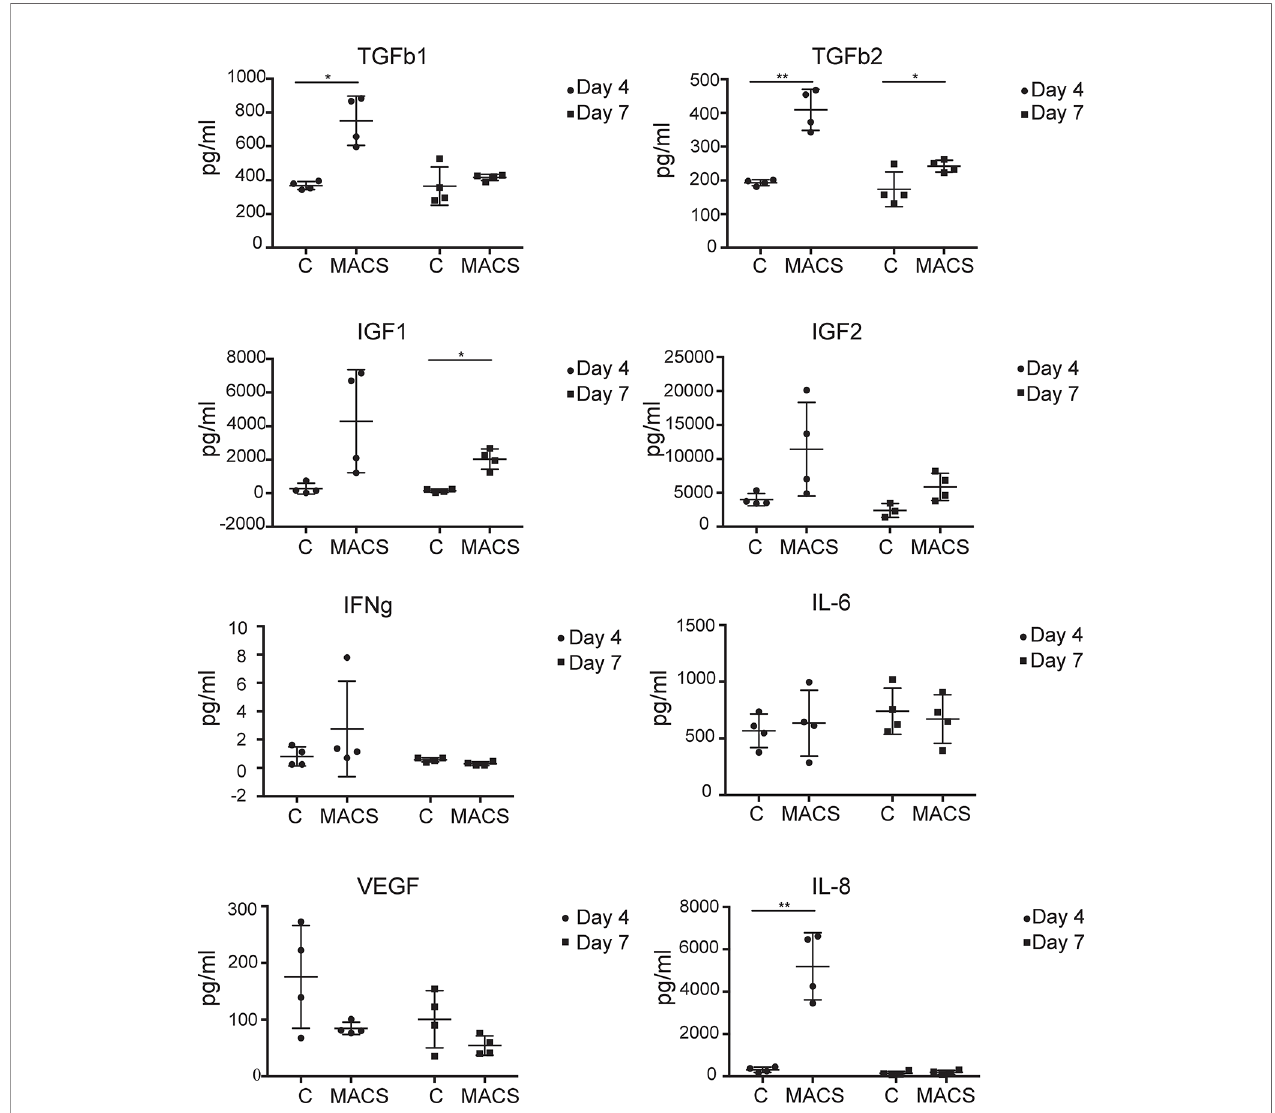
FIGURE 4 | MACS-derived adipose-derived stem cell (ASC) differentially secrete key paracrine-effect proteins compared to culture-derived ASC. Milliplex ® multiplexed assay panels were used to assess the expression levels of key secreted proteins thought to be involved in the paracrine effect of ASC. Each panel represents the expression level of a speci fi c protein (TGFb1, TGFb2, IGF1, IGF2, IFNg, IL-6, and VEGF as indicated) present in the media supernatant from culture- derived ASC (C) or MACS-derived (MACS), in both cases 4 days or 4 – 7 days (day 7) post plating at equal densities. Data derived from four donors. * denotes a p value of < 0.05, ** denotes a p value of <